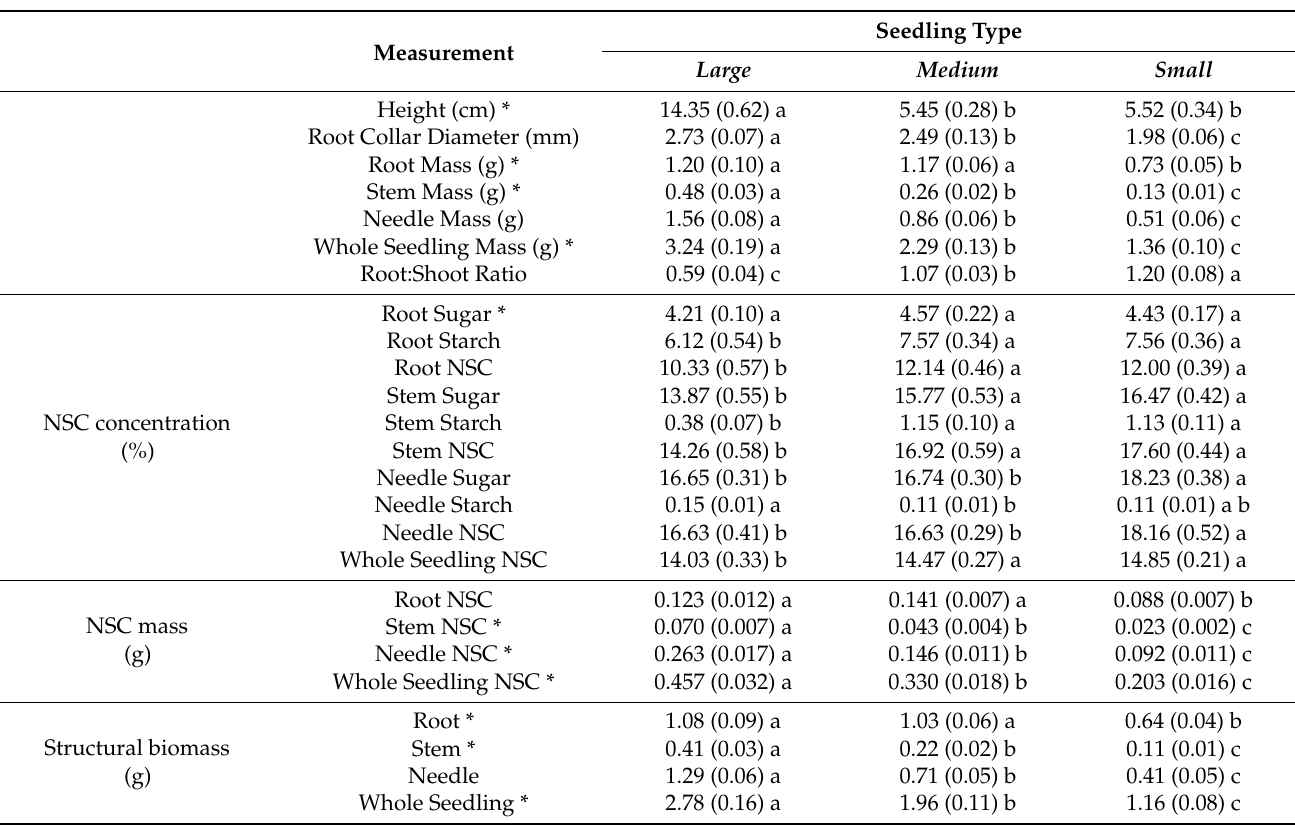
Table A2. Summary of initial measurement means ( ± SE) for pine by seedling type. Different letters indicate significant differences among seedling types using Tukey’s HSD post hoc tests ( p ≤ 0.10, n =